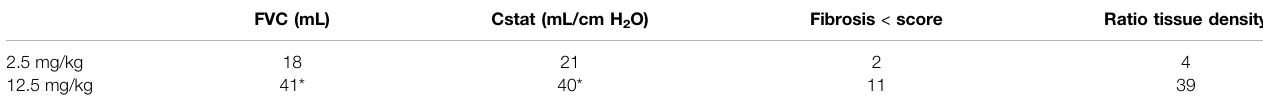
TABLE 3 | Effects of BI 1015550 in the mouse bleomycin model. Results are given as % improvement by the indicated BI 1015550 doses administered b.i.d. compared to bleomycin control. Bleomycin was administered intratracheally in an application volume of 2 mL/kg body weight. BI 1015550 (in 0.5% hydroxyethylcellulose) was administered via oral gavage in a dose volume of 10 mL/kg b.i.d., from day 8 to day 13. *, p < 0.05 based on adjusted covariant analysis (ANCOVA). ANCOVA, analysis of covariance; b.i.d., twice daily; Cstat, static lung compliance; FVC, forced vital